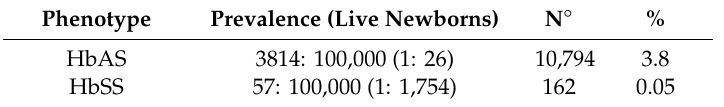
Table 2. Prevalence of haemoglobin S in newborns in the state of Maranh ã o, 2013–2015.